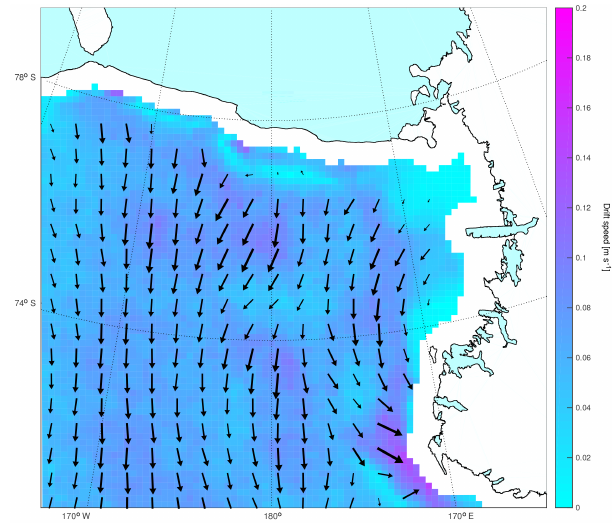
Figure 7. Mean sea ice motion vectors in the Ross Sea region. Ar- rows indicate the mean sea ice drift vector over a 100 × 100km region. The color scale indicates the magnitude of this vector